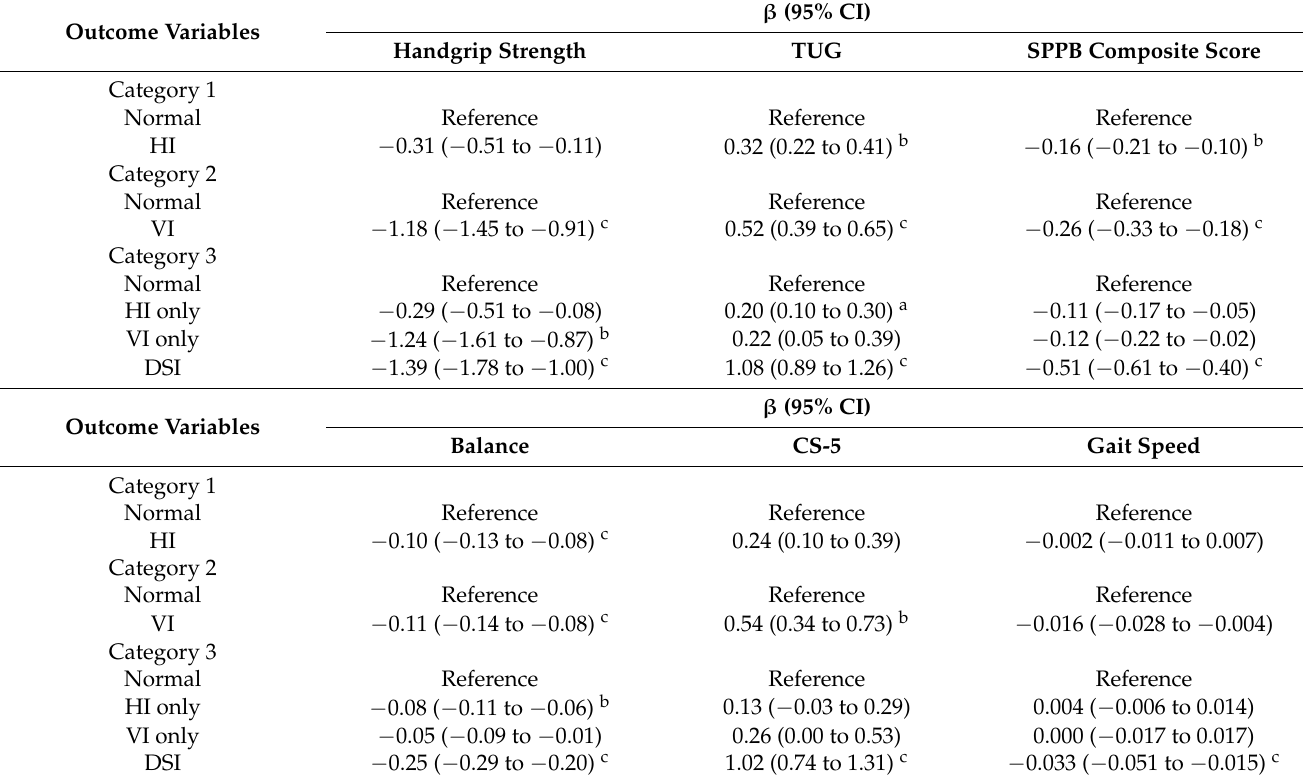
Table 2. Association of sensory impairment with physical function (cross-sectional